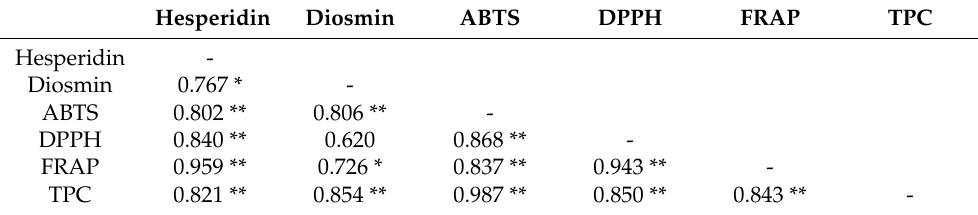
Table 2. Correlation coefficients between flavonoids content, antioxidant activity and total phenol content ( n = 9) after freeze drying treatment.